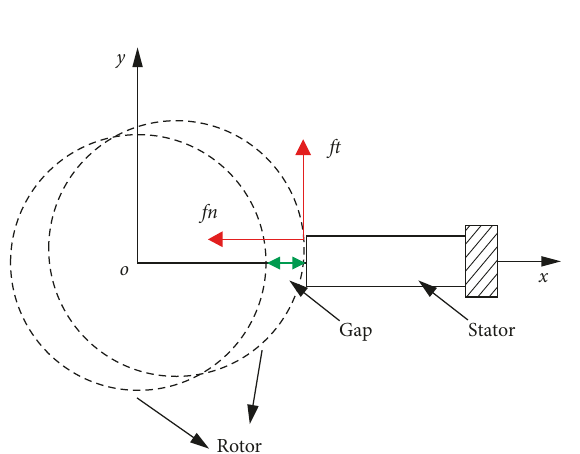
Figure 1: Dimensions of the asymmetric rotor.